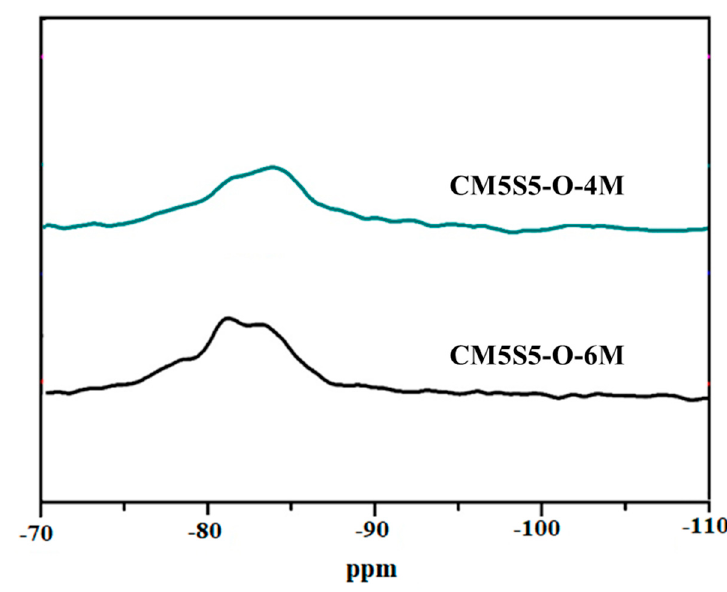
Figure 8. 29 Si NMR spectrum of marble-based geopolymer concrete. Table 6. Fraction area of silicon sites after curve fitting.